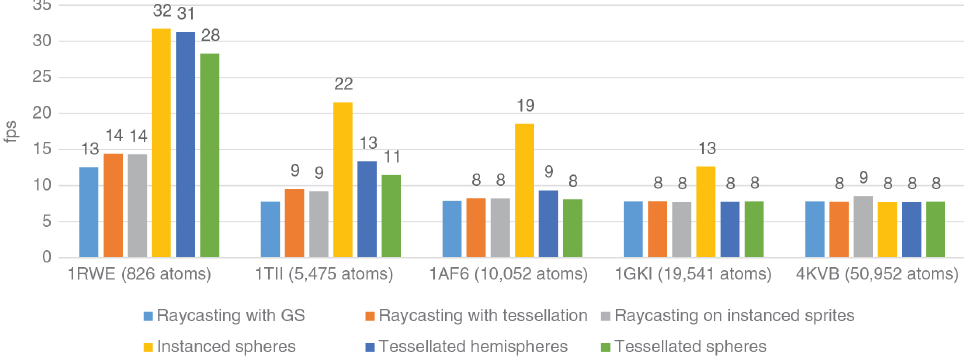
Figure 6: Average frame rates during a full rotation around the data set at 1 m